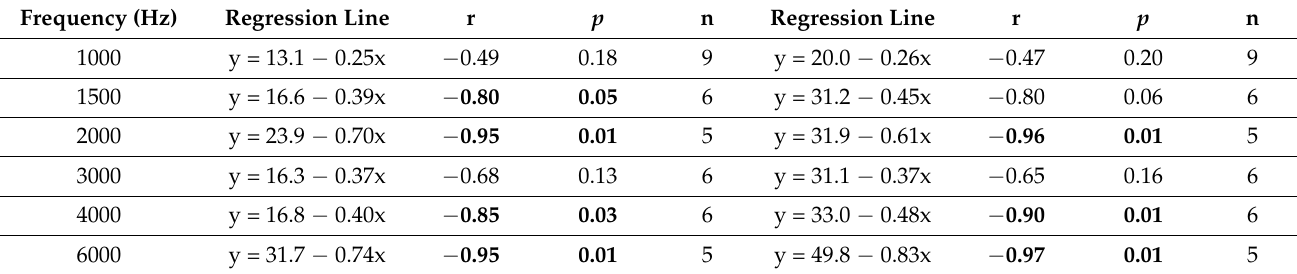
Figure 4. 2f1-f2 distortion product otoacoustic emission (DPOAE) level as a function of pure-tone threshold (PTT) at 1000–6000 Hz (PTT ≤ 60 dB HL). Linear regression analysis revealed DPOAE level (dB SPL) = 18.0 – 0.43 ∙ PTT (dB HL), r = − 0.76, p = 0.00000, n = 37. ○ , □ , ◇ , △ , + , and 🞼 denote 1000, 1500, 2000, 3000, 4000, and 6000 Hz, respectively (n = 9, 6, 5, 6, 6, and 5, respectively). See regression equations for DPOAE vs. PTT at the various f2 frequencies in Table 1. Table 1. Regression analyses of 2f1-f2 distortion product otoacoustic emission (DPOAE) level (SNR ≥ 0 dB; left part) and 2f1-f2 DPOAE SNR vs. pure-tone threshold (PTT; right part) at various frequencies (PTT ≤ 60 dB HL).